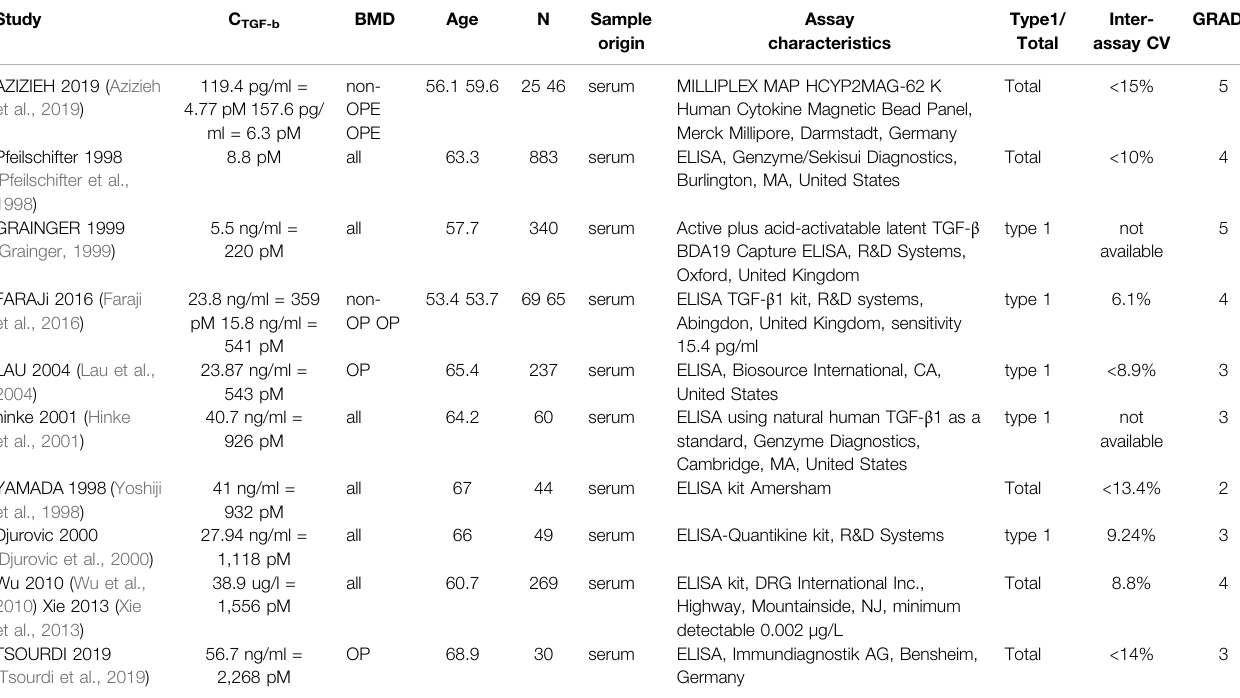
TABLE 8 | TGF- β concentration measurements in postmenopausal women, in ascending order.